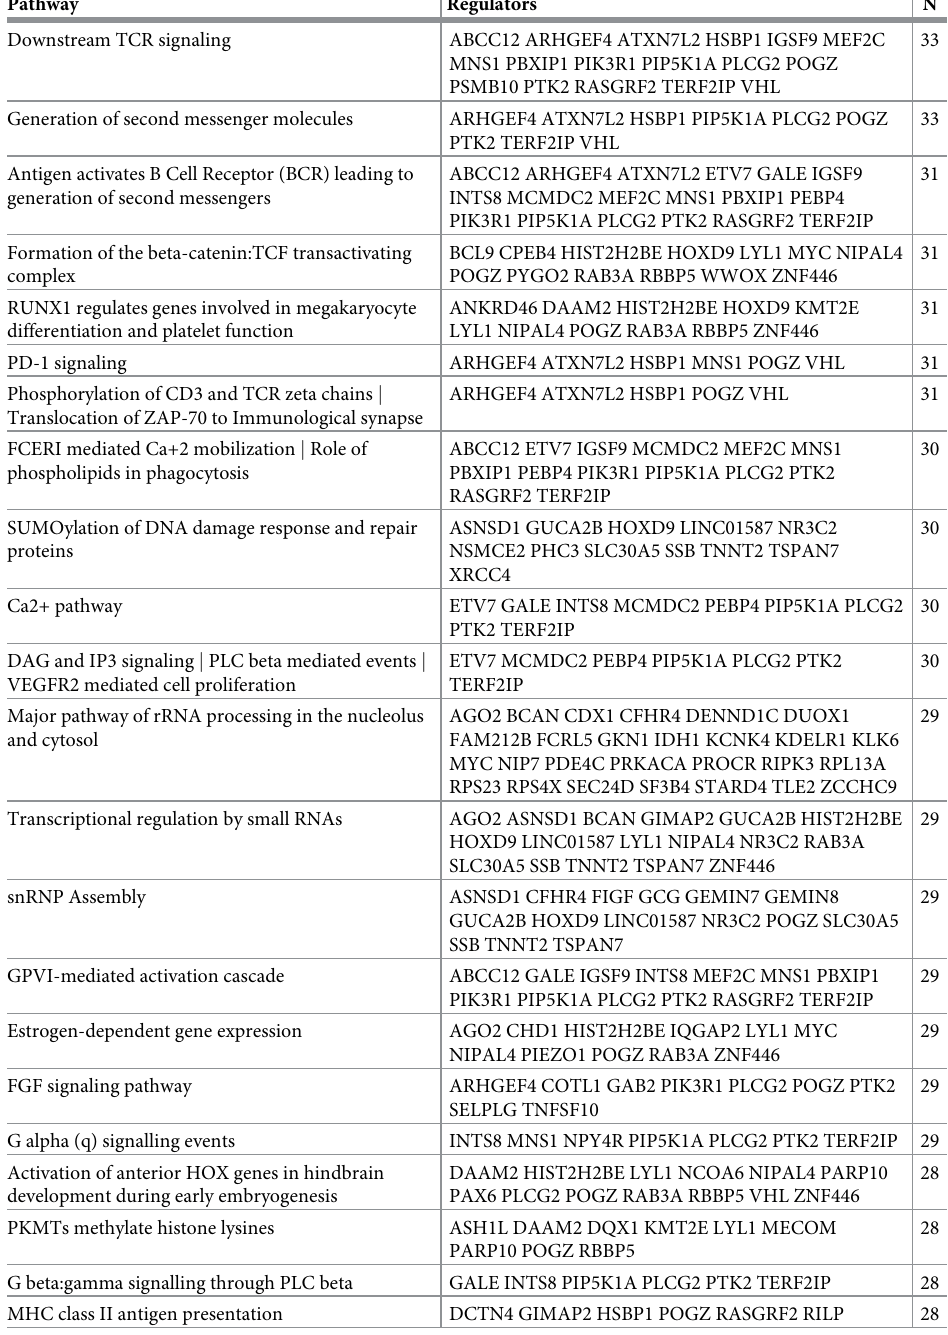
Table 3. Most disrupted pathways in the 45 datasets used in the analysis.